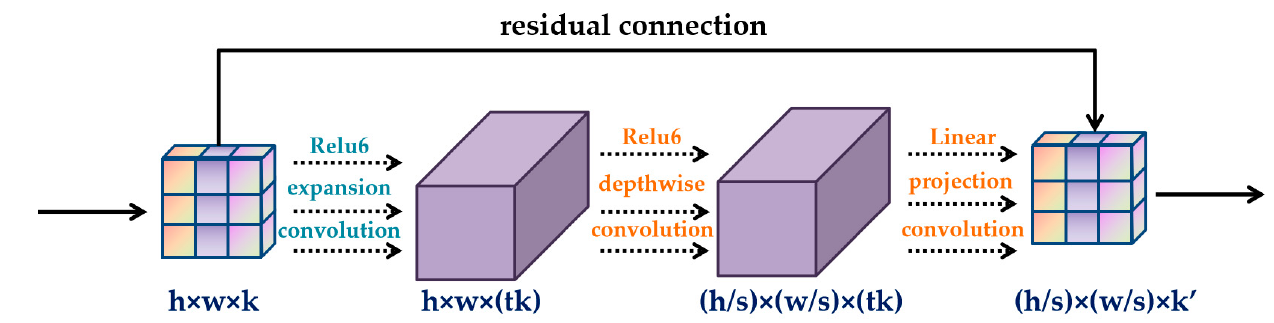
Figure 1. Basic structure of mobilenetV2.